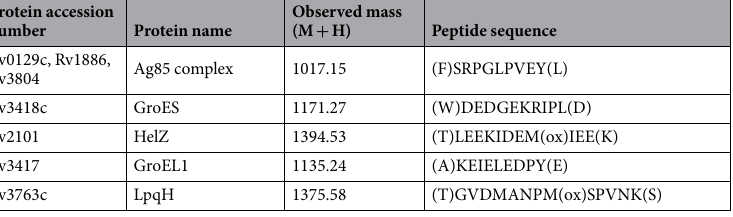
Table 2. Peptides identified from LC-MS analysis of fraction 9 of pronase-digested WCL from the X4-19 Δ HspX Mtb strain.